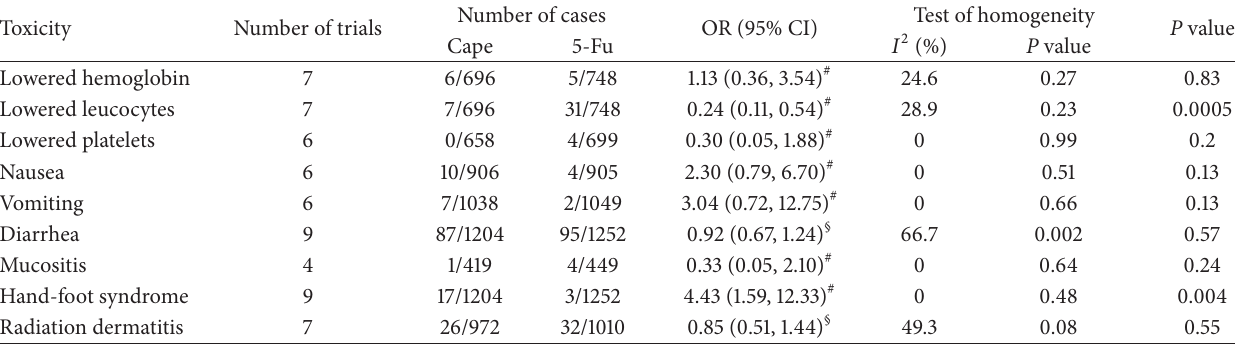
Table 2: Toxic (grade 3 or worse ∗ ) effects in trials comparing capecitabine with 5-Fu.